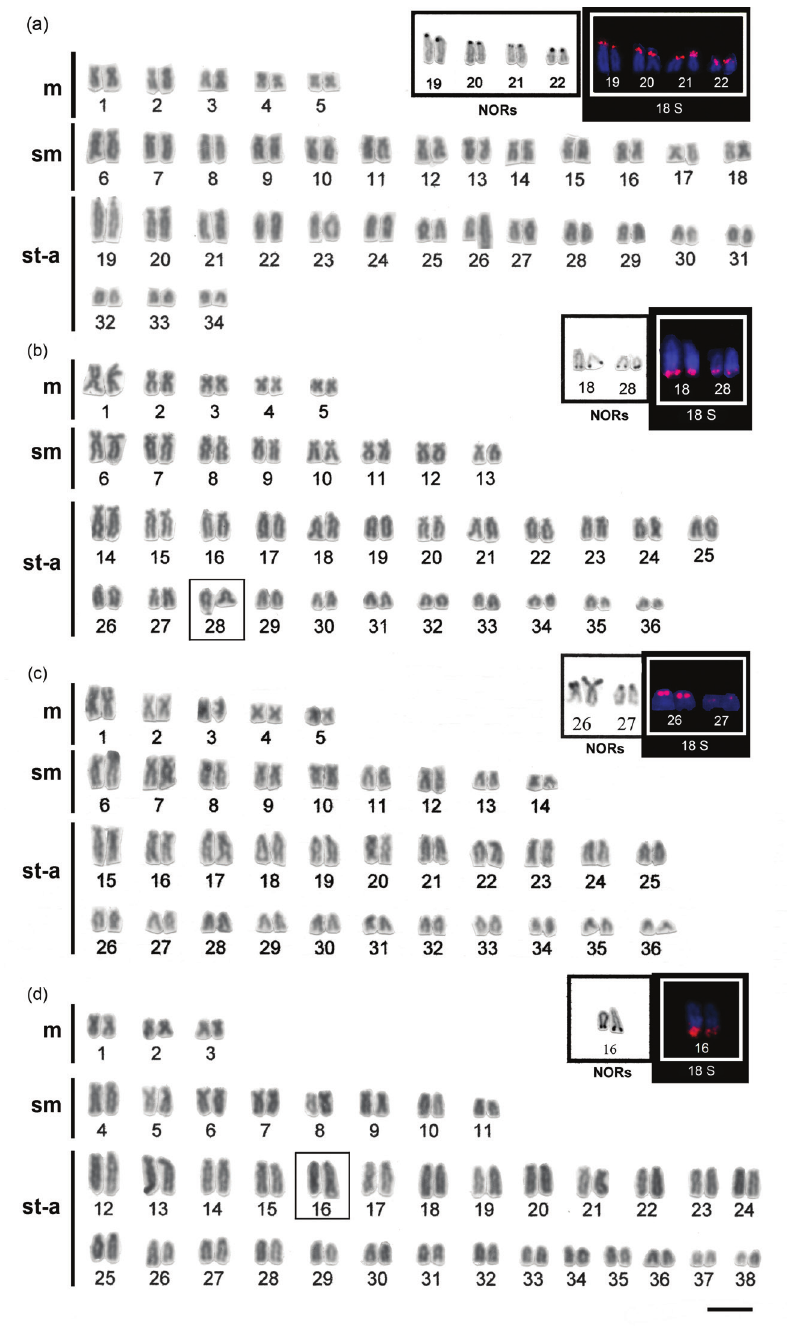
Figure 1. Karyotypes of a H. ancistroides b H. strigaticeps c H. regani d H. paulinus arranged from Giemsa-stained chromosomes. In the insets, partial karyotypes of the NOR-bearing chromosome pairs after Ag-staining (left) and FISH with 18S rDNA probe (right). Bar = 10 µ